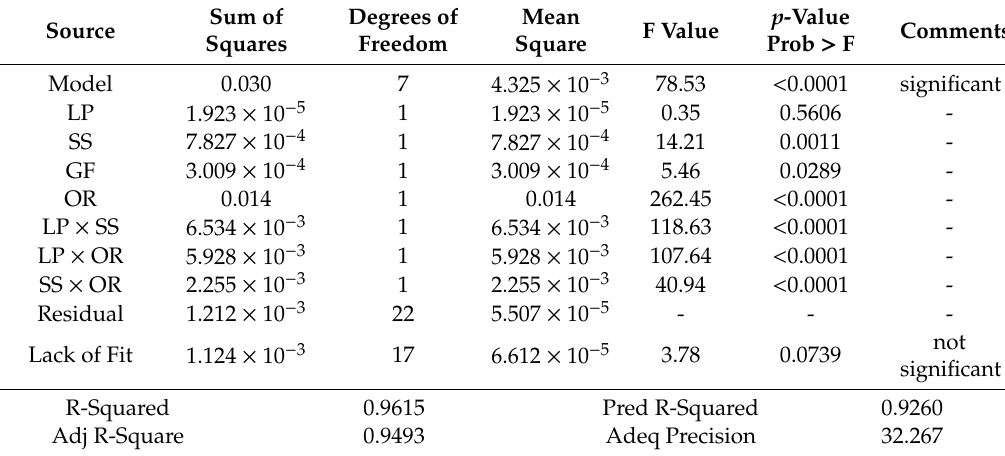
Table 6. Analysis of variance on flatness